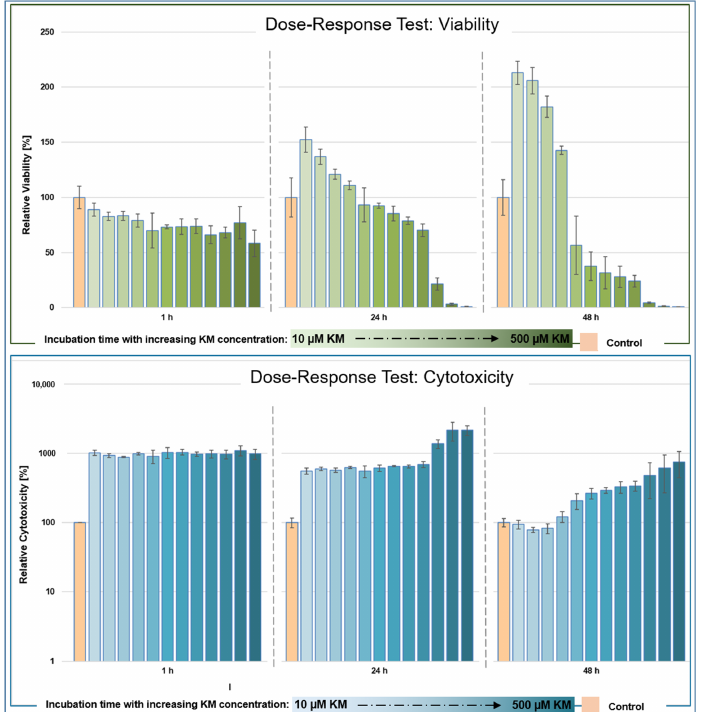
Figure 1. Dose–response test of kitasamycin (KM) in human Tenon’s fibroblasts (hTFs). Cell ‐ based multiplexed luminescence and fluorescence real ‐ time assays were used to measure viability and cytotoxicity. The hTF cells (2500 cells/well) were seeded in a 96 ‐ well plate and incubated with dif ‐ ferent KM concentrations (hTFs + 10, 25, 50, 75, 100, 125, 150, 175, 200, 300, 400 and 500 μ M KM) for a total of 48 h. Untreated hTFs served as the control. Each concentration was measured fourfold. Viability measurements (top) and cytotoxicity measurements (bottom) were performed at regular intervals after KM addition. Left: measurement after 1 h; middle: measurement after 24 h; right: measurement after 48 h. The values were normalized to untreated hTFs .